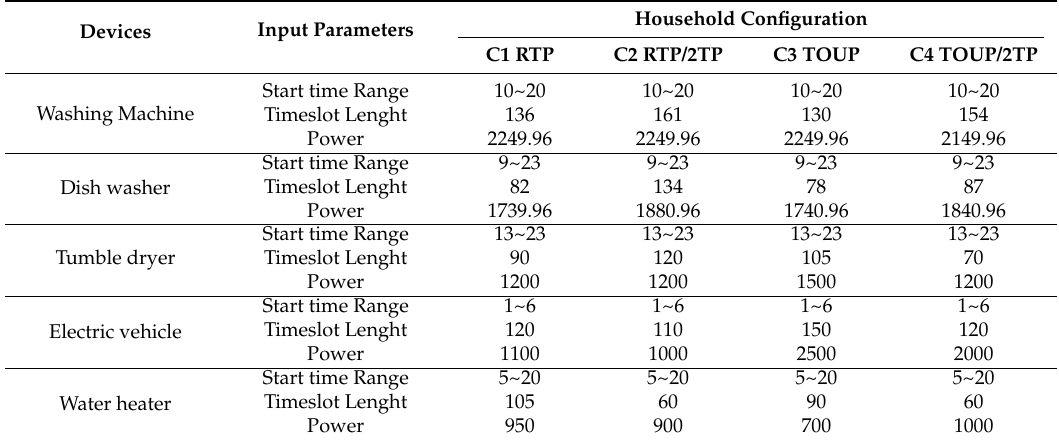
Table A1. Configuration for five appliance scheduling with dynamic pricing [30].